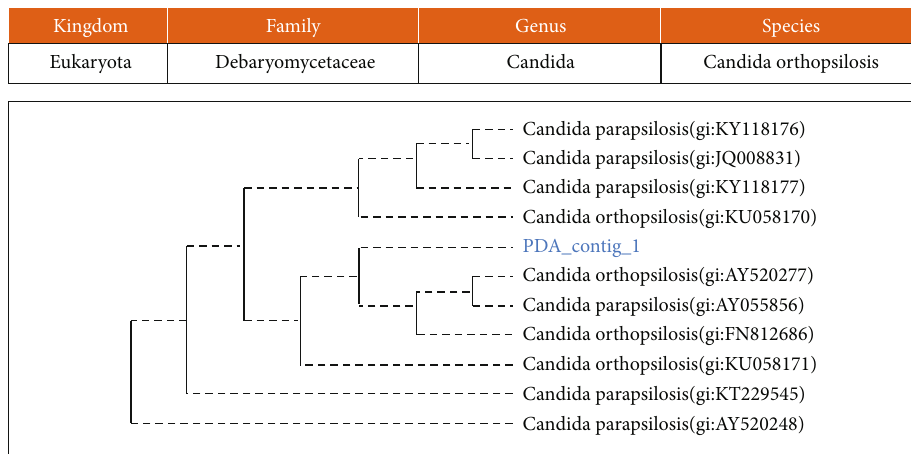
Figure 2: The phylogenetic study of isolate PDA/MRS